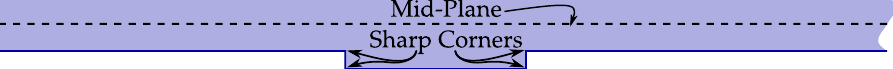
Figure 1. An exaggerated diagram showing a ‘hidden tamper’. The tamper is not symmetrically placed about the mid-plane and will therefore induce mode conversion between the two types of guided elastic